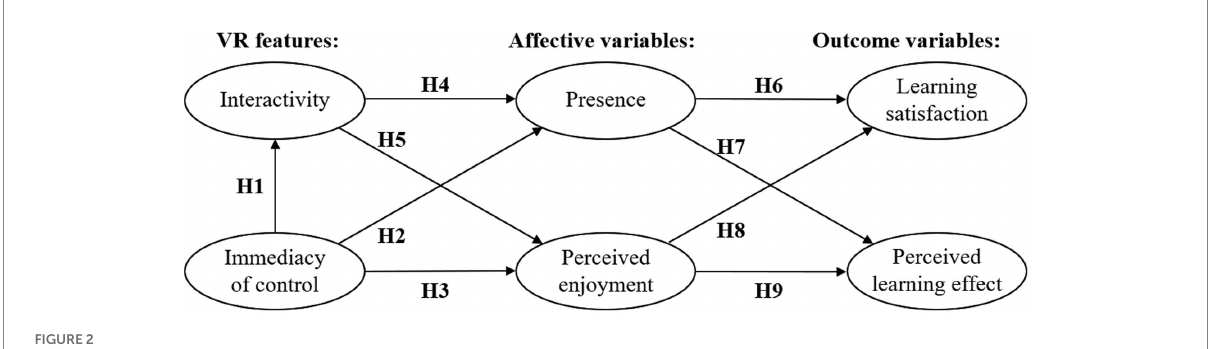
FIGURE 2 Hypothetical